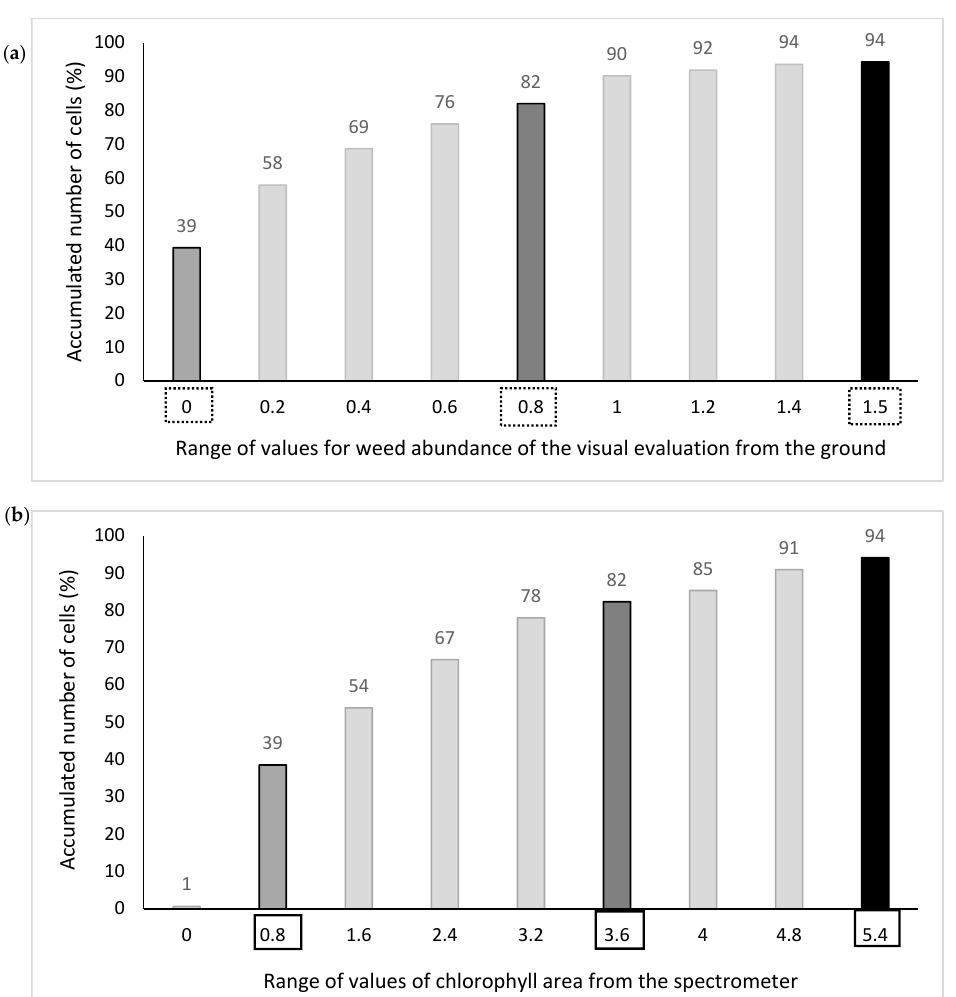
Figure 5. Histograms of the accumulated percentage of number of cells (7 m × 7 m) in the range of values of Field I: ( a ) for the visual weed evaluation from the ground (method 1), and ( b ) for the weed map from the spectrometer. Note: Weed tolerance thresholds for reference methods 1 and 2 are squared with a dotted black line. The three selected threshold values for the spectrometer are squared with a continued black line.